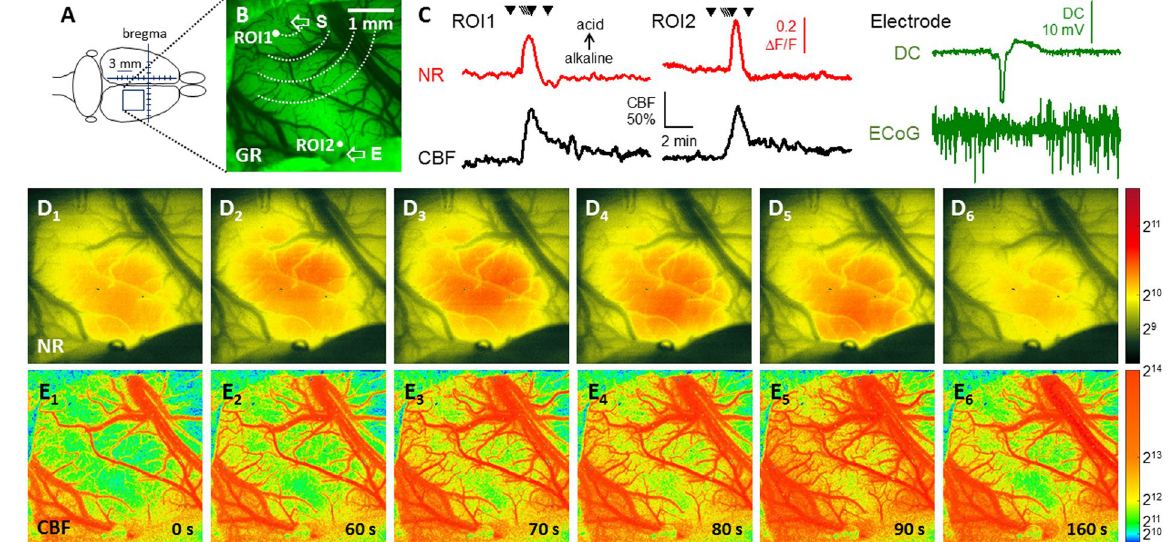
Figure 1. Representative raw image sequences and graphs illustrate synchronous changes in Neutral Red (NR) fluorescence, cerebral blood flow (CBF), direct current (DC) potential and the electrocorticogram (ECoG) with the propagation of a spreading depolarization (SD) wave in the intact cerebral cortex of a young rat. ( A ) Position of the closed cranial window over the parietal cortex. ( B ) The cortical surface at green light illumination. Two regions of interest (ROI) indicate the origin of NR and CBF traces shown in Panel C. The tip of the capillary used to trigger SD (S), and the penetration site of the glass capillary electrode (E) inserted to acquire electrophysiological signals are shown with arrows. ( C ) Traces demonstrate SD-related relative changes in NR fluorescence (red) and CBF (black). The occurrence of SD was confirmed by the negative shift of the DC potential and the transient depression of the ECoG (green). Small black triangles pointing down over the NR traces designate the origin of the representative images shown in Panels D,E. ( D ) Pseudo-colored images of NR fluorescence demonstrate a propagating increase of fluorescence intensity associated with SD; the original images relying on a 16-bit grayscale. A scale bar to the right represents the used color range. ( E ), Pseudo-colored perfusion maps based on laser speckle contrast images (in 16-bit resolution) show the CBF response with SD, and display speckle contrast perfusion units. Warmer colors represent higher CBF. A scale bar to the right represents the used ranges of gray